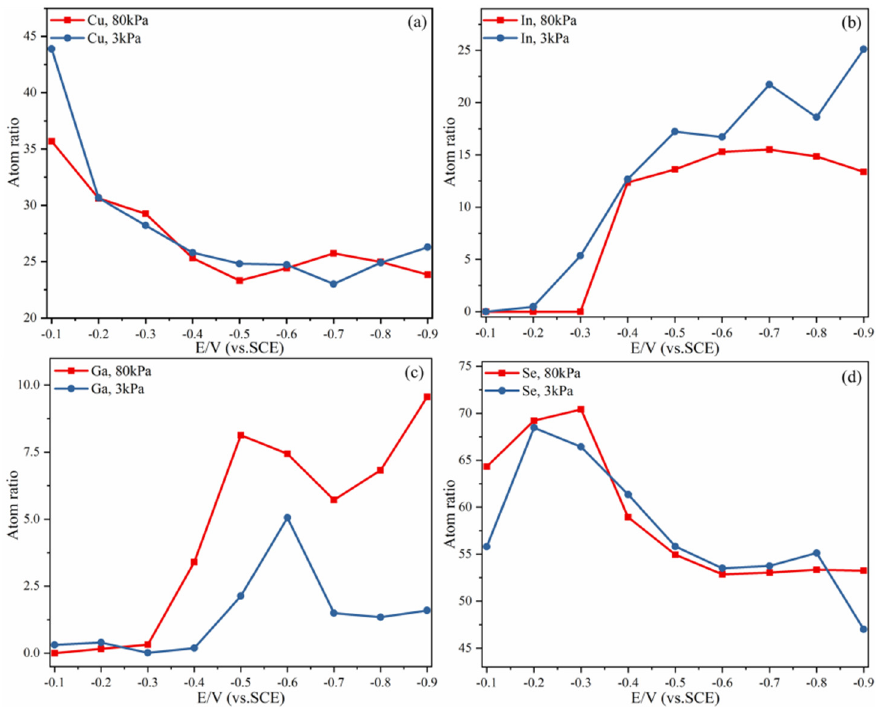
Figure 7. EDS composition curves of ( a ) Cu, ( b ) In, ( c ) Ga, and ( d ) Se in CIGS thin films.